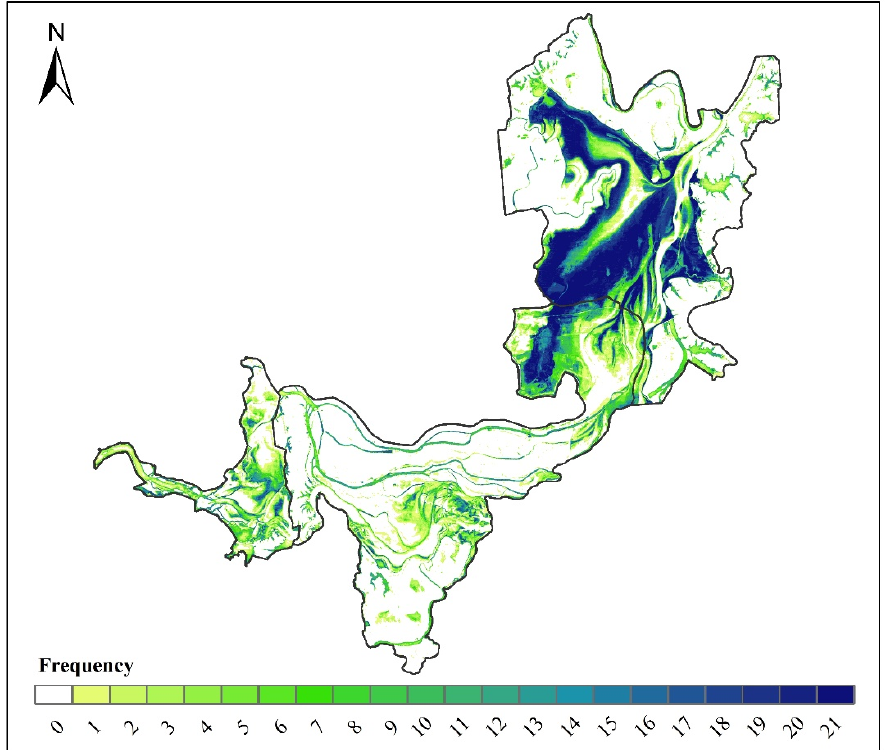
Figure 8. Spatiotemporal dynamic changes in seasonal wetlands. Note: The numbering 0–21 reflects the number of seasonal wetland occurrences in the same location from 2000 to 2020.